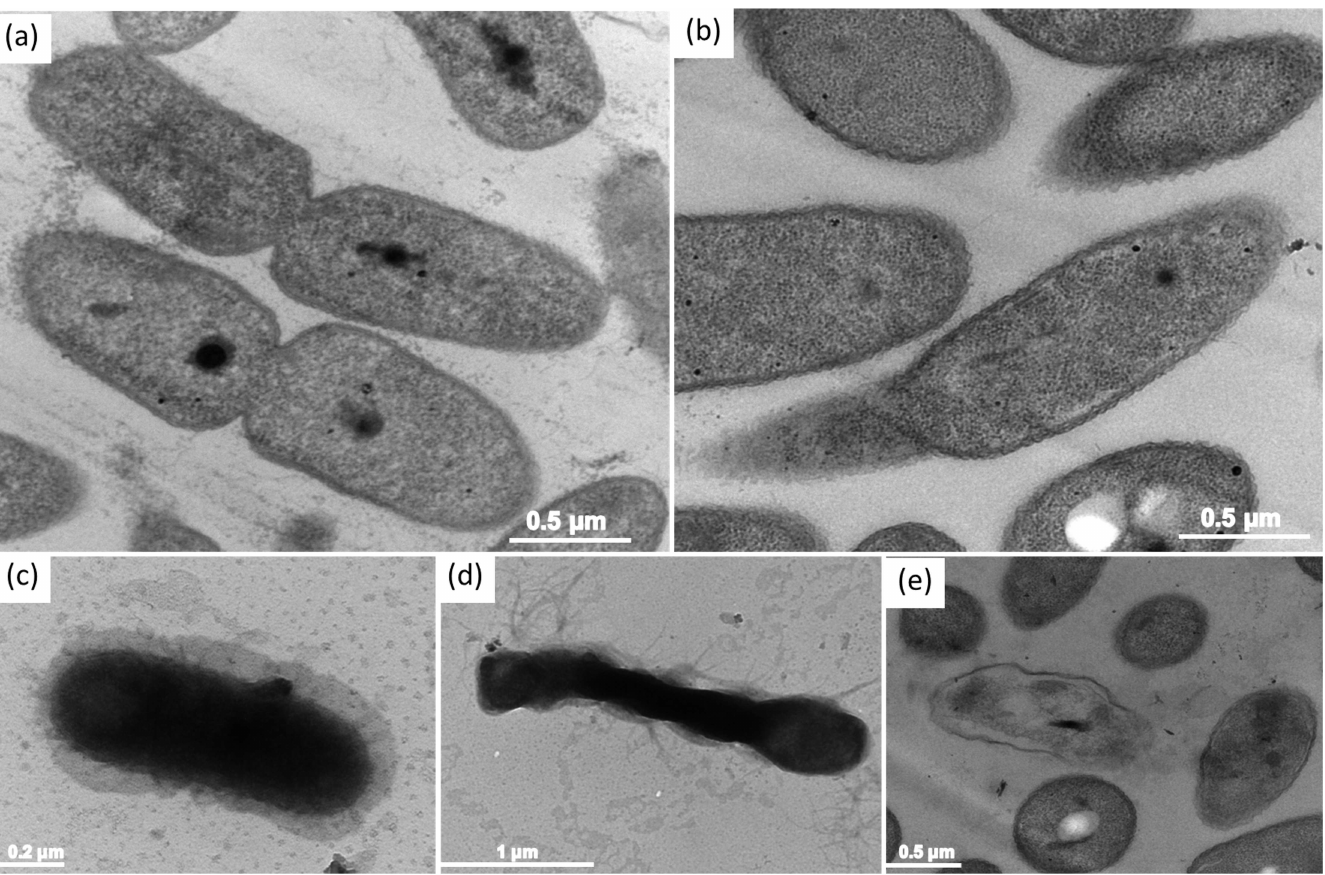
Fig 8. Ultrastructural changes of B . pseudomallei 316c cells after exposure to AgNPs. TEM micrographs preparedby ultramicrotome for ultra-thin sections show (a) untreatedcells, (b-d) cells exposedto 1/5 MIC of AgNPs and (e) cells exposedto MBC for 1 hr at 37˚C. Dashedarrows show nucleoidof B . pseudomallei 316c, and asterisk